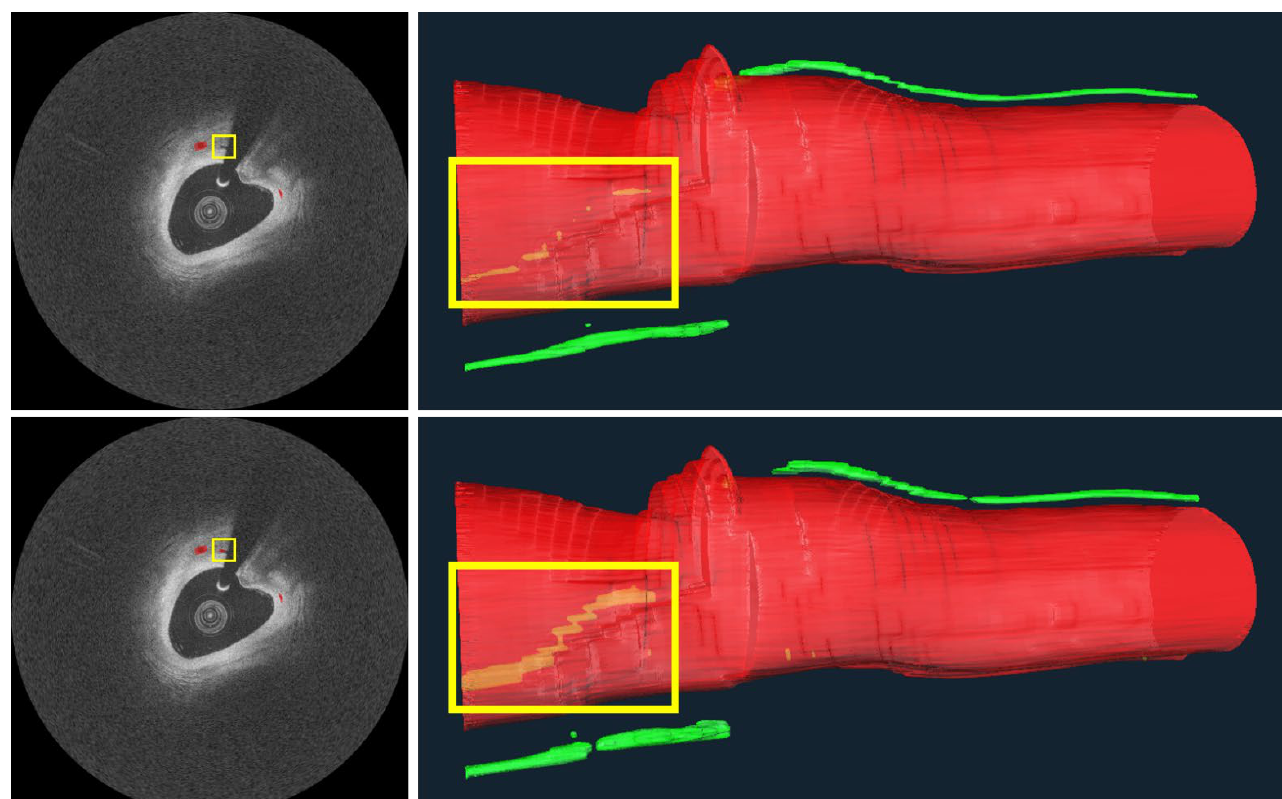
Figure 9. Microvessels from a representative IVOCT pullback in a plaque. On the right are 3D visualizations from manual ( top ) and automated ( bottom ) microvessel segmentations, as well as the vessel lumen. Microvessels look very similar between the top and bottom, except for within the yellow bounding boxes, showing a microvessel “behind” the vessel lumen. In this latter instance, the microvessel from the automated analysis is much more continuous than that from the manual analysis, indicating that the automated method detects more actual microvessel instances than the manual analysis. Missing annotations in the manual analysis are evident in the original IVOCT images on the left, where an annotation is missing despite image evidence. The longest microvessel is ~7.4 mm in length with a diameter of about ~107.4 µm. The red is lumen and the green is a microvessel.